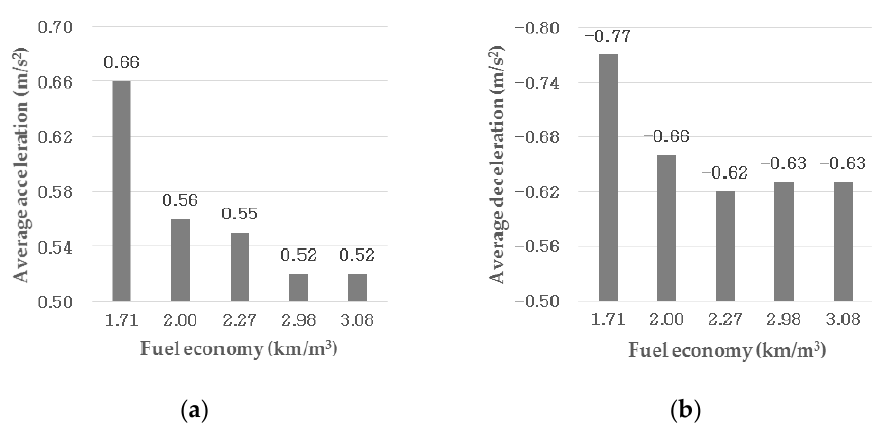
Figure 1. Average vehicle speed gradient: ( a ) average acceleration according to fuel economy; ( b ) average deceleration according to fuel economy.